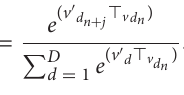
structures, which were commonly used in previous drug–target prediction